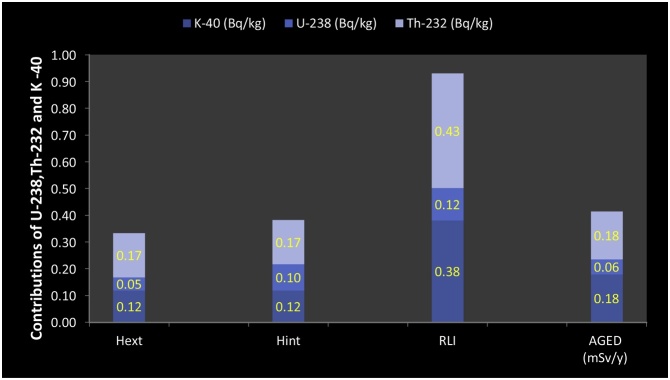
Contributions of 40K, 238U and 232Th to Hext, Hin, RLI and AGED.